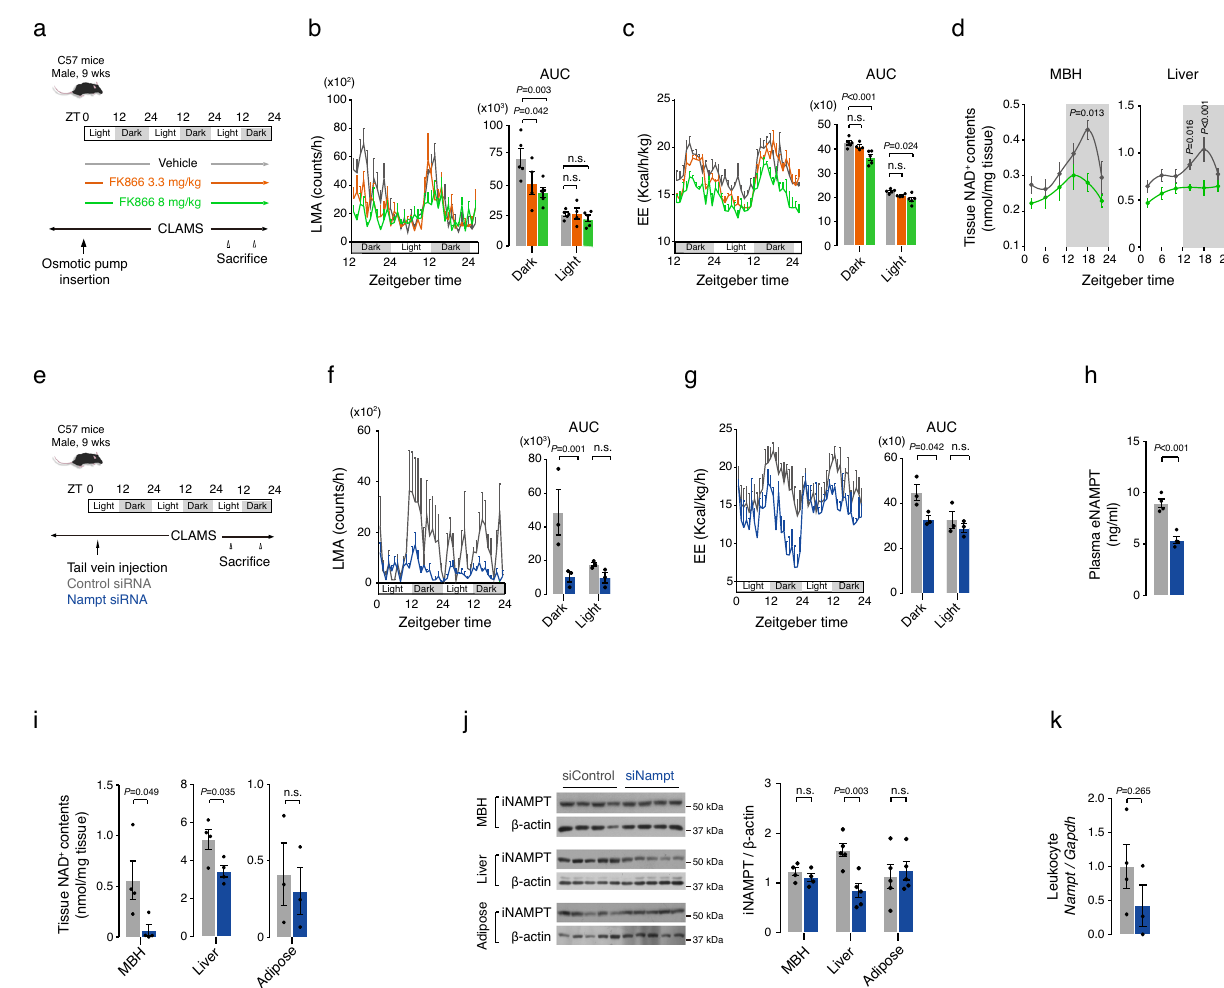
Fig. 2 | Blockade of plasma eNAMPT activity abrogates circadian rhythms of locomotor activity and energy expenditure. a Schematic diagram of the sys- temic FK866 study. ZT: zeitgeber time. b , c Systemic FK866 infusion-induced changes in circadian fl uctuations in locomotor activity (LMA) ( b ) and energy expenditure(EE)( c )(VehicleandFK8668mg/kg, n =5;FK8663mg/kg, n =4mice). Two-wayANOVAfollowed byFisher ’ s LeastSigni fi canceDifference(LSD) test. n.s.: not signi fi cant. d The mediobasal hypothalamus (MBH) and liver NAD + levels throughoutacircadiancycleinmicethatreceivedanintraperitoneal(i.p.)infusion of either FK866 8mg/kg or vehicle for 3 days ( n =5 mice at each time points). Repeated measures ANOVA followed by Fisher ’ s LSD test. The shaded area in the fi gures represents the lights-off period. e Schematic diagram of the systemic Nampt siRNA (siNampt) study. f , g Effects of systemic administration of siNampt